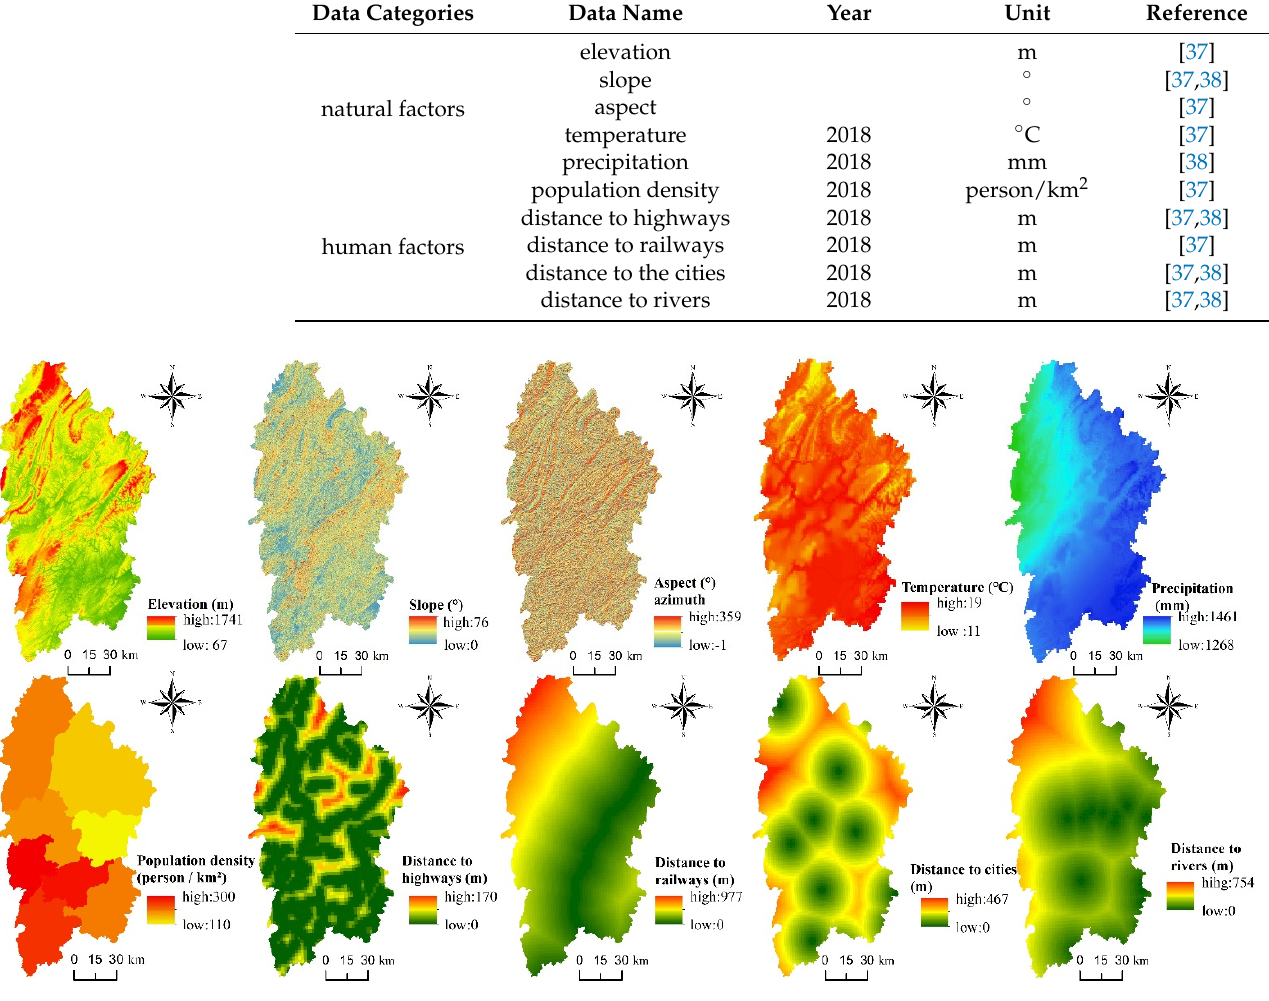
Figure 2. Driving factors of agricultural land use change.